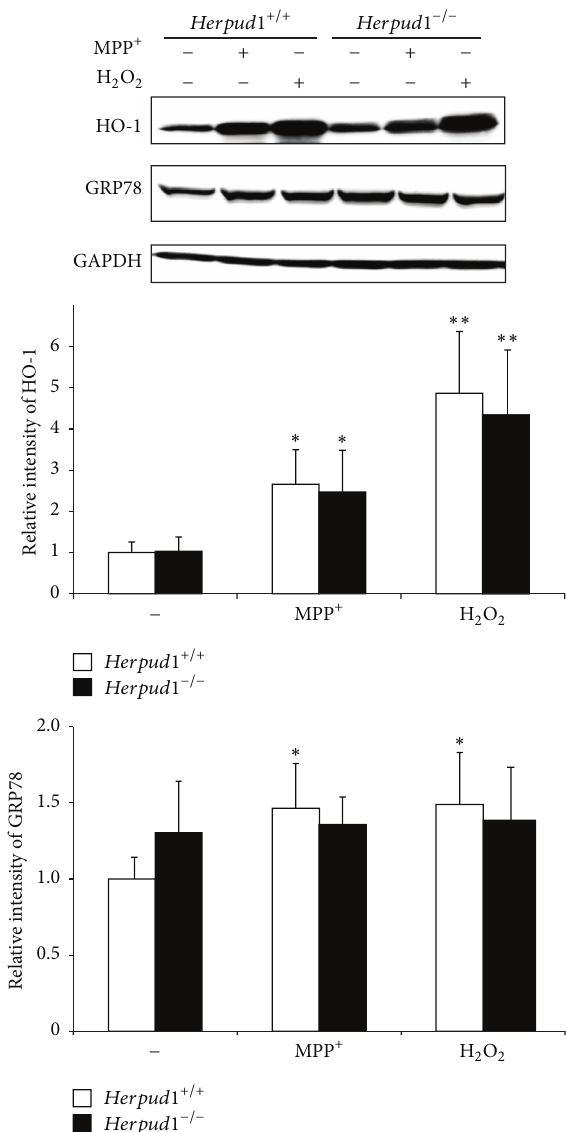
Figure 4: Expression of stress-related genes in cultured astro- cytes. Herpud1 +/+ and Herpud1 −/− mice-derived astrocytes were treated with MPP + for 16h, and, after cell lysis, protein samples (30 𝜇 g/sample) were subjected to western blotting for HO-1, GRP78, and GAPDH. Each value shown is the mean ± SD ( 𝑛 = 4 ), and the value derived from Herpud1 +/+ astrocytes without MPP + treatment is designated as one. ∗ 𝑃 < 0.05 ; ∗∗ 𝑃 < 0.01 , compared to cells without MPP +